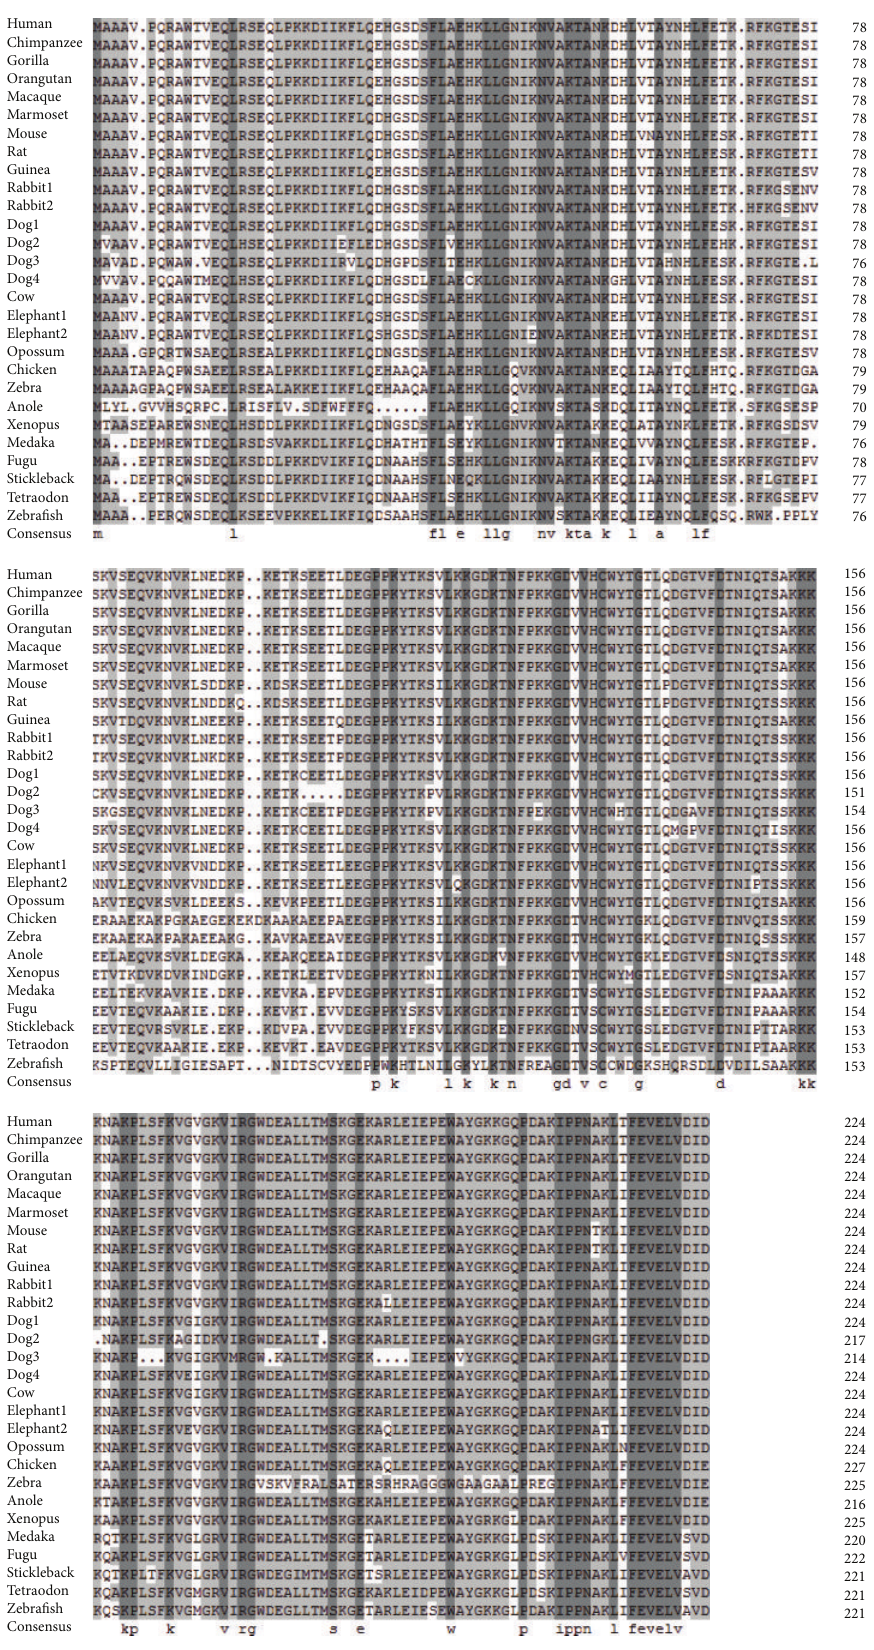
Figure 1: Sequence and structural alignment of